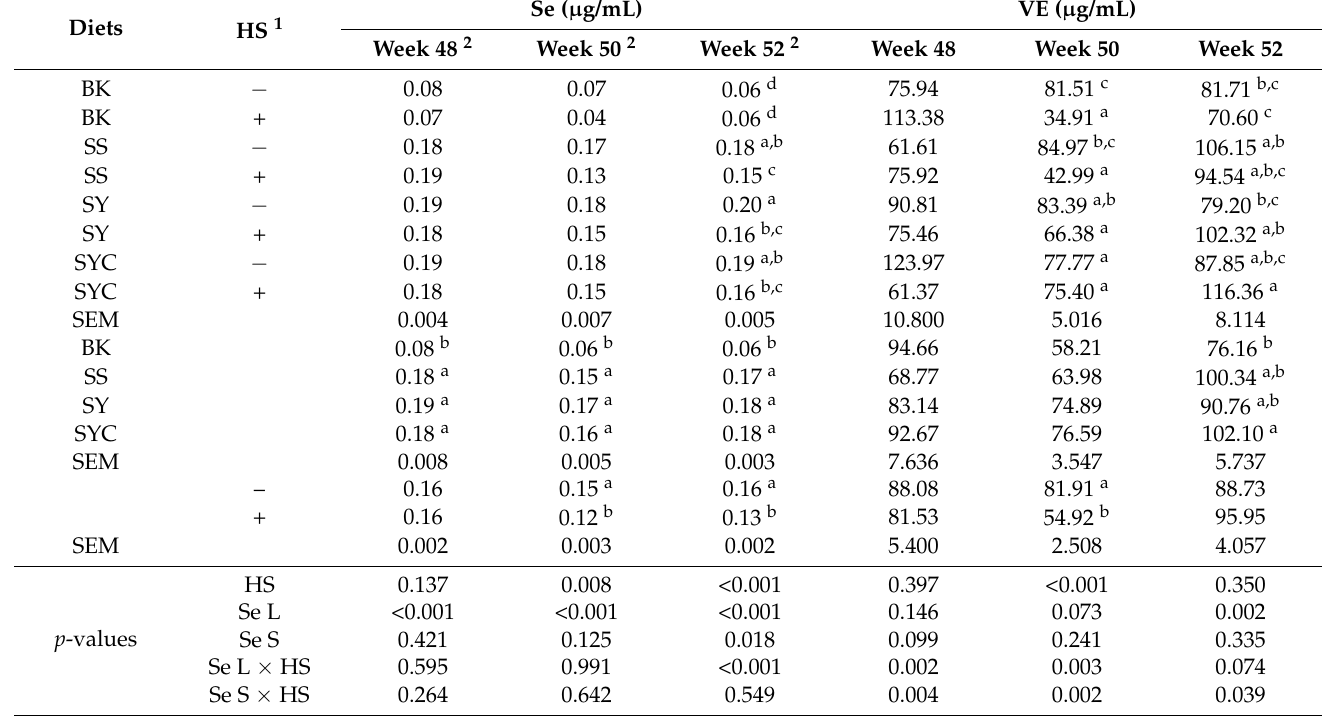
Table 5. Effects of different Se sources in diet on Se and VE content in serum of laying